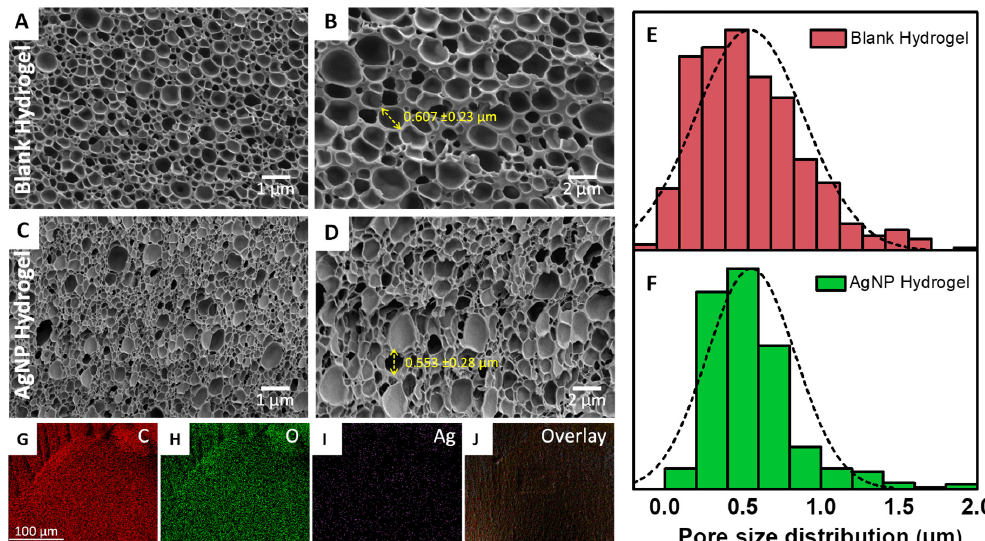
Figure 3. ( A – D ) SEM micrographs of both blank and AgNP hydrogel at two different magnification 10K X (left panel) and 20K X (right panel). The yellow arrow shows the representative pore size. ( E , F ) Hydrogel size distribution of both blank and AgNP-loaded hydrogel. ( G – J ) EDS elemental mapping of carbon (C), oxygen (O), silver (Ag), and overlay images.